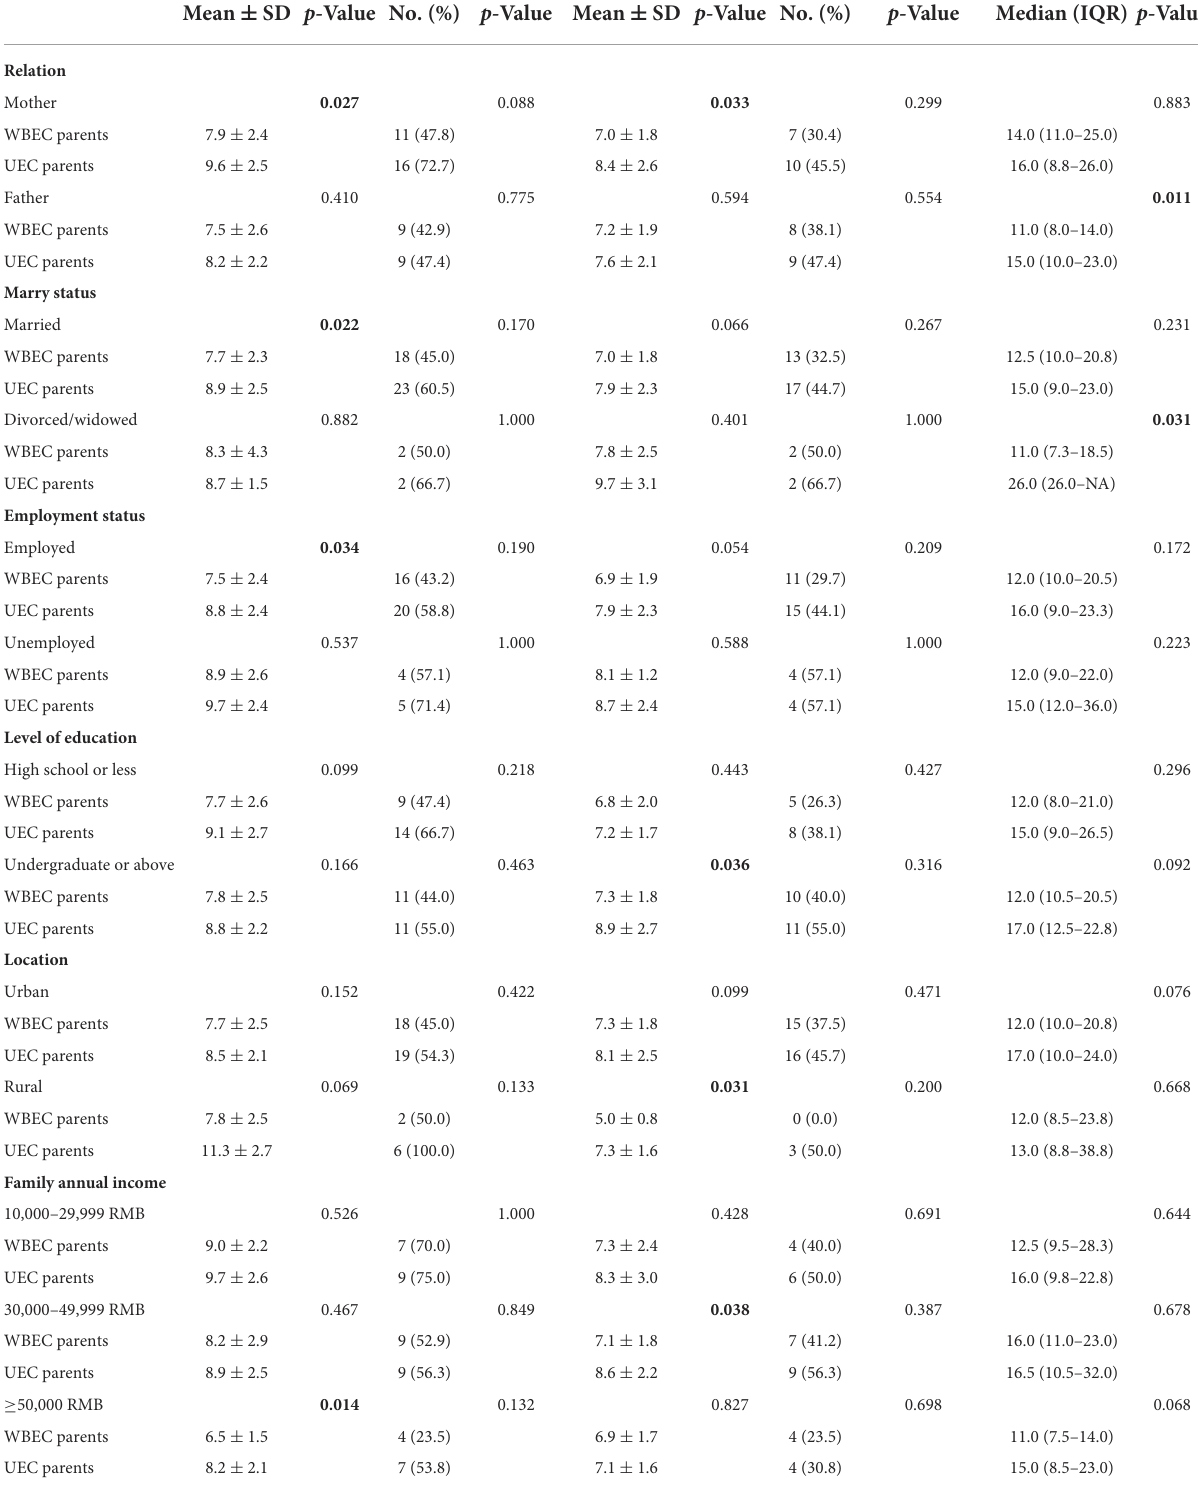
TABLE 3 Subgroup analysis of HADS score, anxiety, depression and IES-R